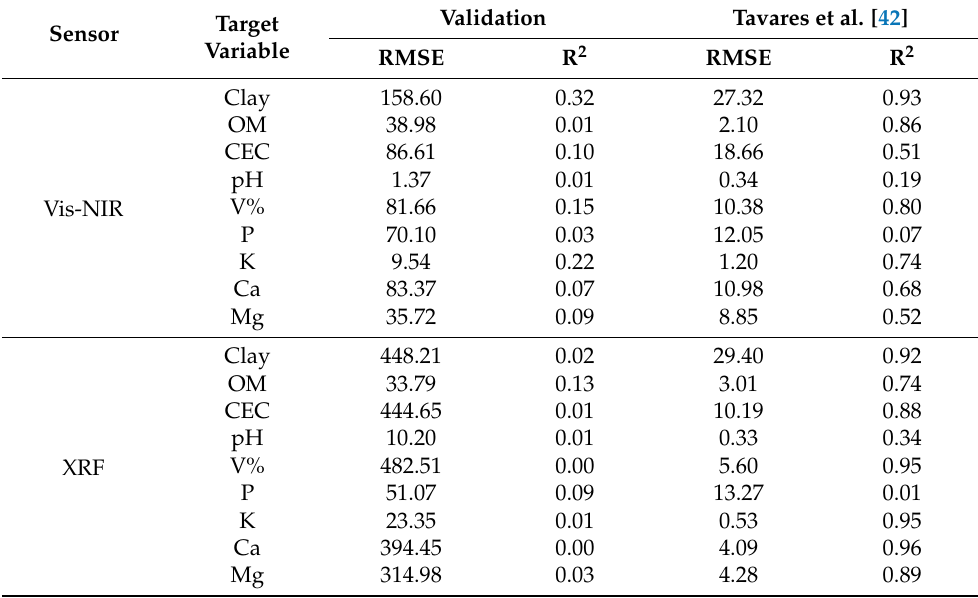
Vis-NIR: visible and near-infrared diffuse reflectance spectroscopy; XRF: X-ray fluorescence spectroscopy; Clay (g kg − 1 ); OM: organic matter content (g kg − 1 ); CEC: cation exchange capacity (mmol c kg − 1 ); pH: potential of hydrogen; V%: base saturation (mmol c kg − 1 ); P: Phosphorus (mmol c kg − 1 ); K: potassium (mmol c kg − 1 ); Ca: calcium